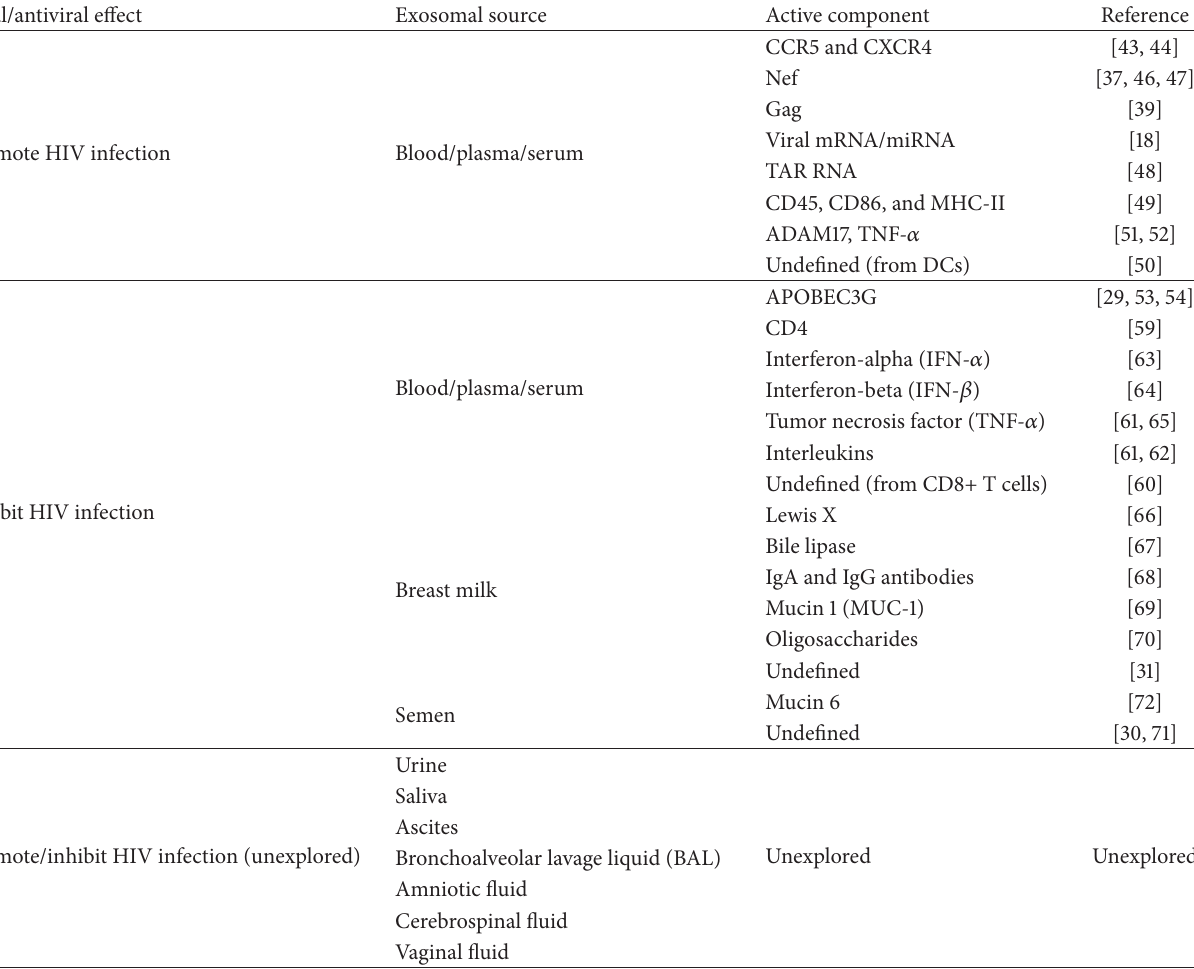
Table 1: Dual effects of body fluids-derived exosomes against HIV